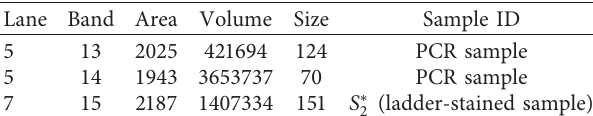
Figure 19: Analysis sheet of the gel electrophoresis technique of DNA fragments using coumarin 3 as a fluorescent stain dye. Table 6: Analysis data of the gel electrophoresis technique of DNA fragments using coumarin